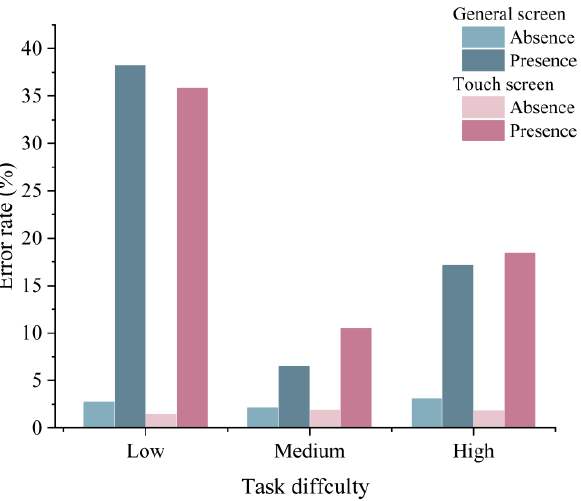
Figure 6. Error rate under different time-pressure, screen-type, and task-difficulty conditions.